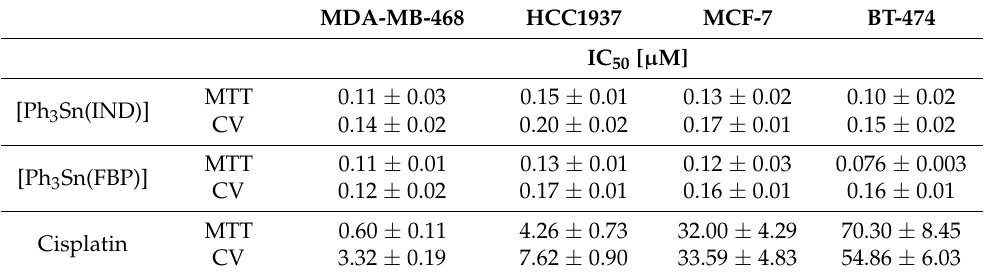
Table 2. IC 50 values (mean ± SD, [ µ M]) of synthesized complexes and cisplatin obtained with MTT and CV assays after 72 h treatment. IC 50 values of the ligand precursors, indomethacin and flurbiprofen, are >100 µ M as found by both MTT and CV assays after 72 h